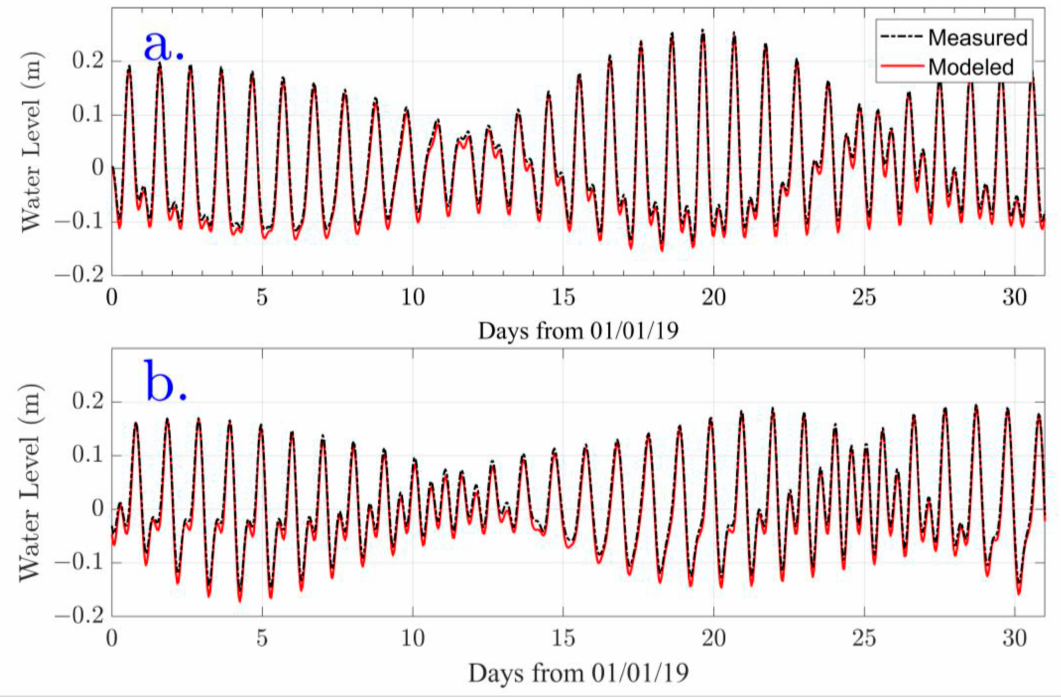
Figure 5 . Comparison of simulated and measured water surface level data, ( a ) calibration period (1 to 31 January 2019), ( b ) validation period (1 to 31 October 2019).